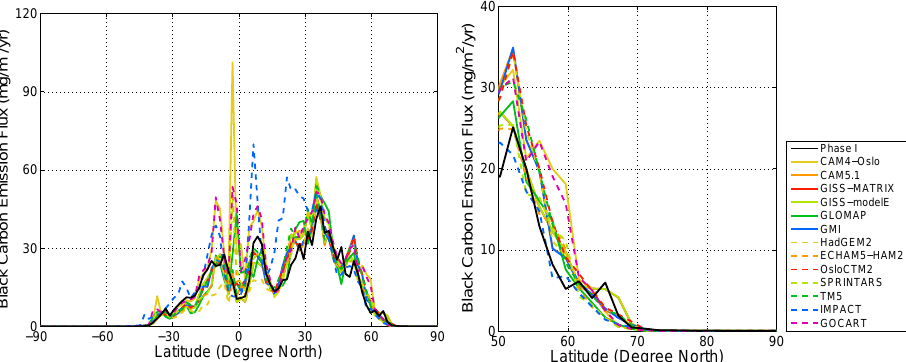
Fig. 5. Annual, zonal-mean black carbon emission fluxes applied in phase I and phase II models for the global (left panel: Fig. 5a) and in more detail in the northern latitude (right panel: Fig. 5b) regions.